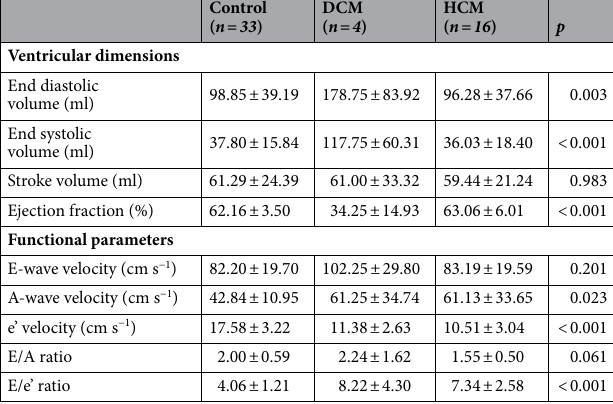
Table 2. Indices for LV dimensions and functional